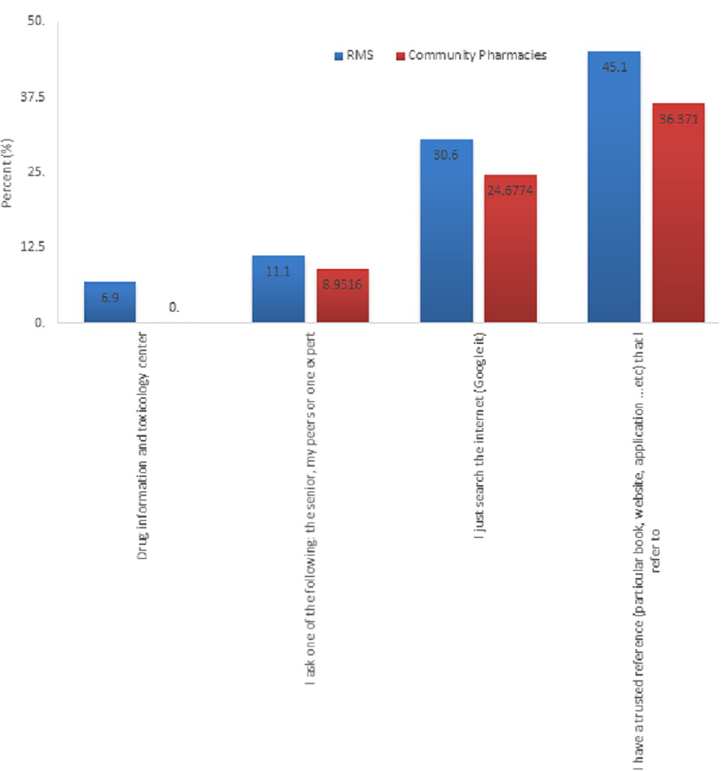
Fig 5. Actions taken for unknown medical information in Royal Medical Services and Community Pharmacies.